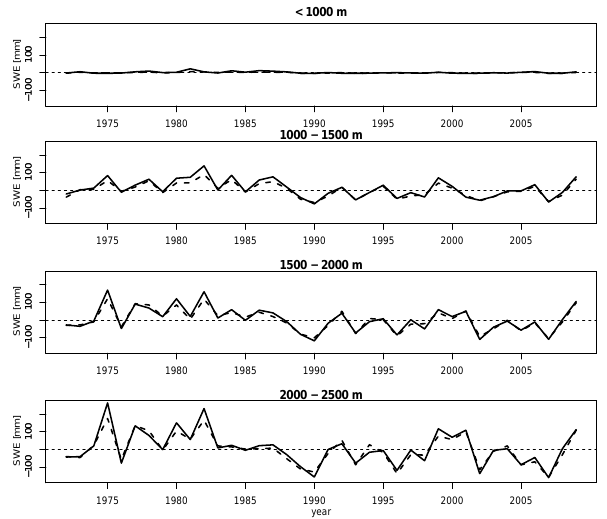
Fig. 11. Anomalies in the median winter SWE [mm] in map110 (black line) and map.cal (dashed line) for different altitude